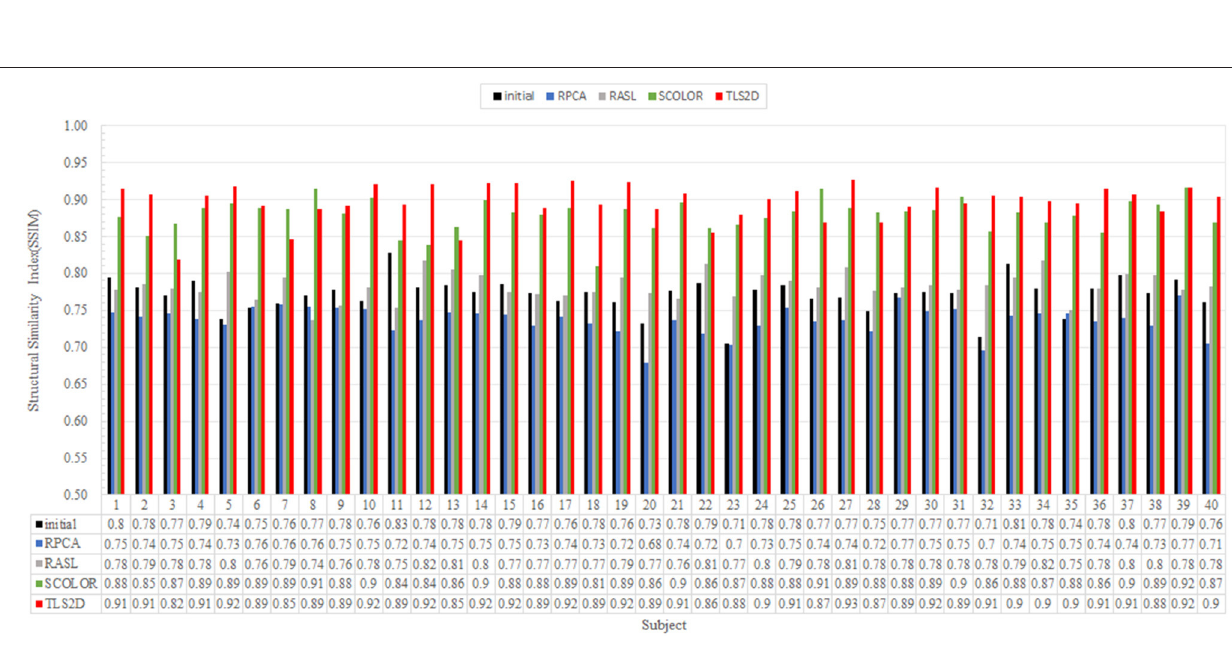
Frontiers in Neuroscience | www.frontiersin.org